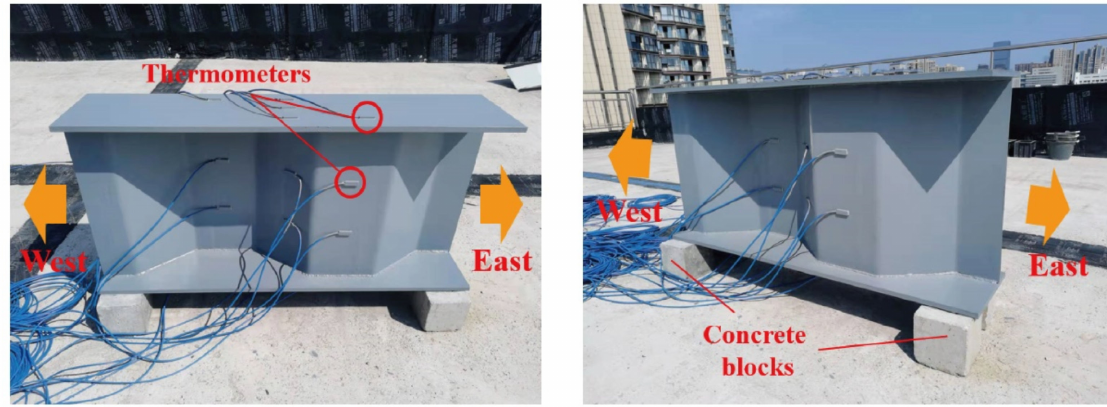
Figure 1. The photograph of the experimental steel beam.